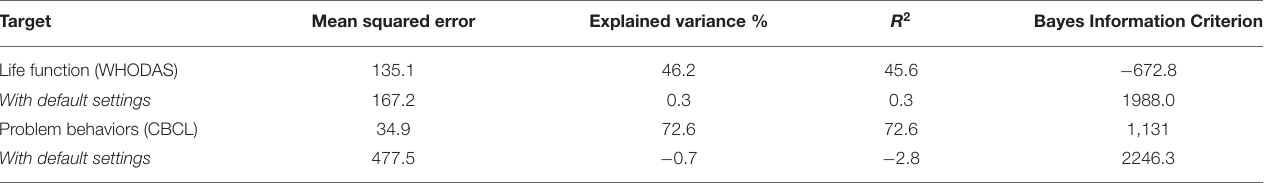
TABLE 4 | Results of regression prediction using deep learning optimized with